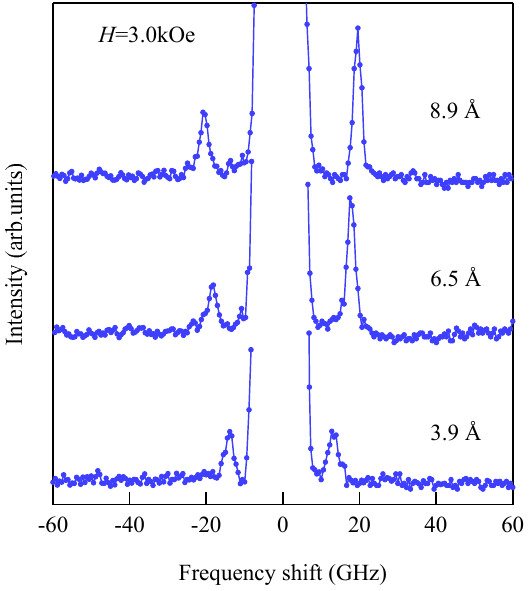
Figure 15. Thickness development of BLS spectra observed at H = 3.0 kOe. The thickness was indicated on each spectrum [79].